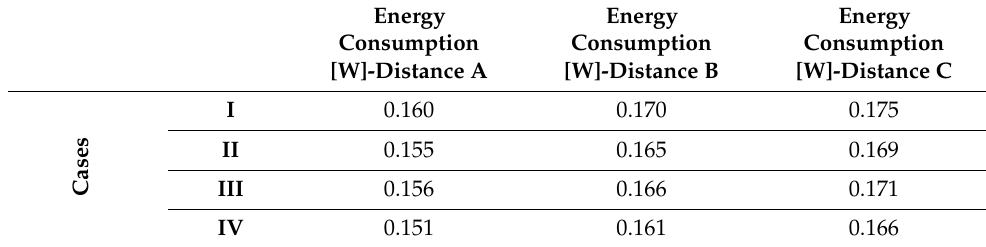
Table 3. Electric energy